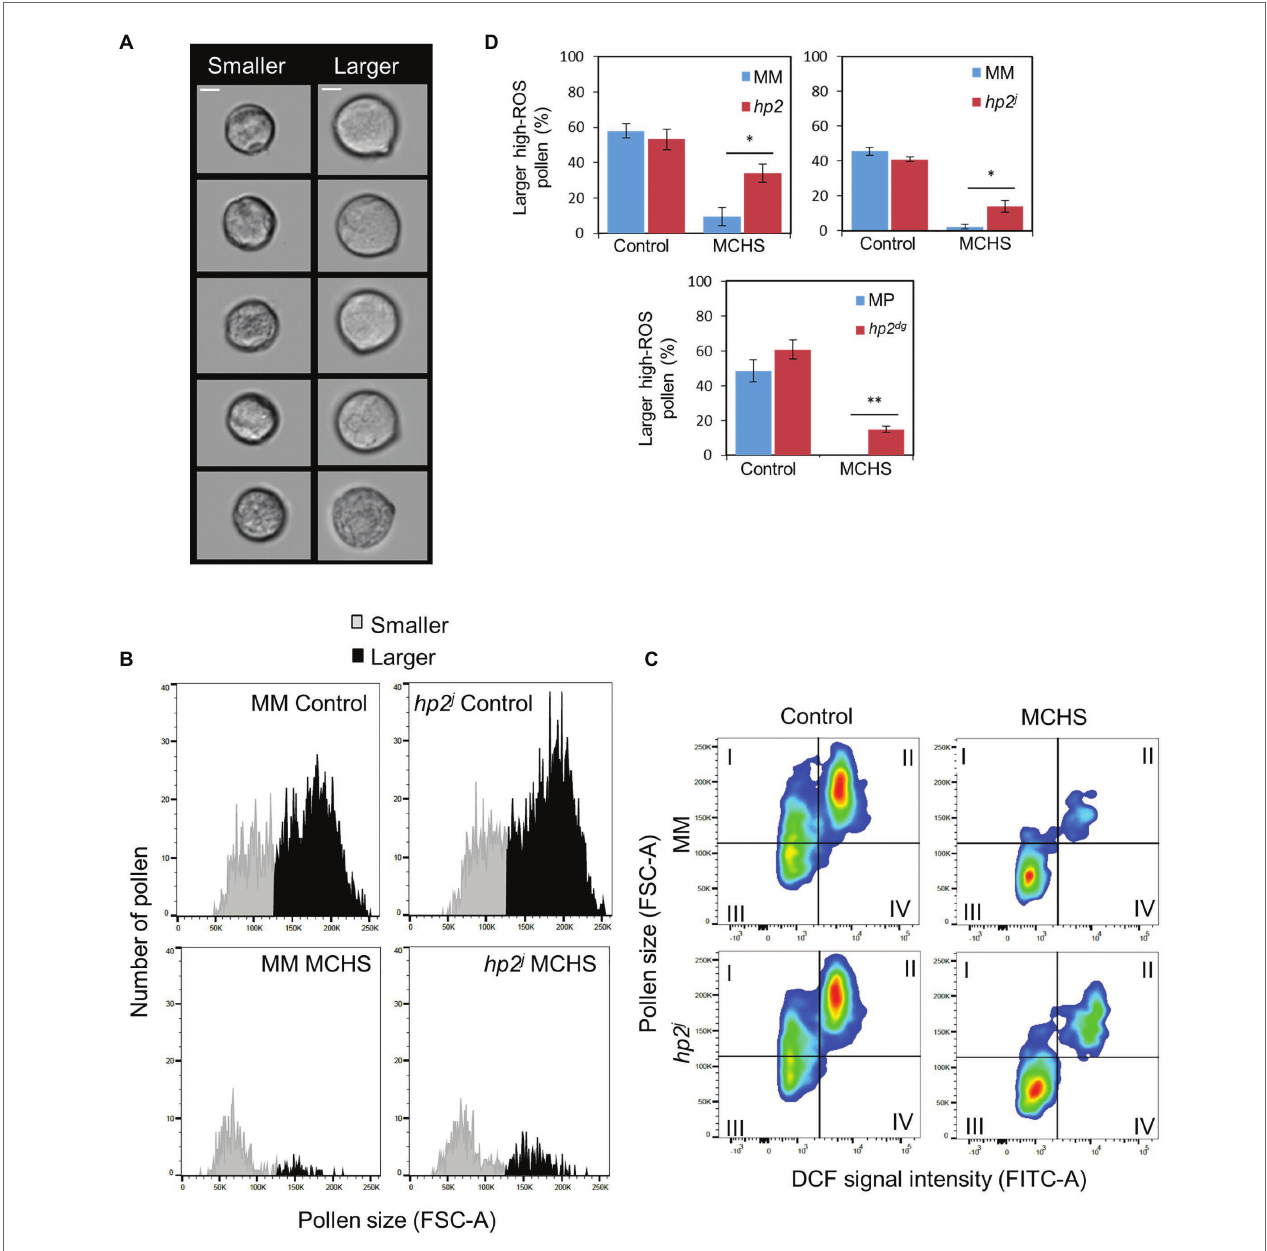
FIGURE 3 | The hp2 mutant maintains a higher proportion of larger pollen under MCHS conditions. (A) Randomly selected pollen grains from smaller and larger subpopulations in a Moneymaker control sample. Scale bar = 10 μ m. (B) Pollen grain size distribution by Forward Scatter Area (FSC-A) in an hp2j sample from control and MCHS conditions. (C) DCF-positive pollen populations plotted by grain size (FSC-A) vs. DCF signal intensity (FITC-A). The larger, high-ROS pollen faction is represented in quadrant II. (D) Rate of larger high-ROS pollen sub-population (quadrant II, section c) in all genotypes under control and MCHS conditions. Bars represent mean larger high-ROS pollen fraction of 3–6 replicates. Error bars represent standard error of the mean. *represents p < 0.05 and **represents p < 0.01. MCHS, moderate chronic heat stress; C, control conditions; MM, moneymaker; and MP, manapal.